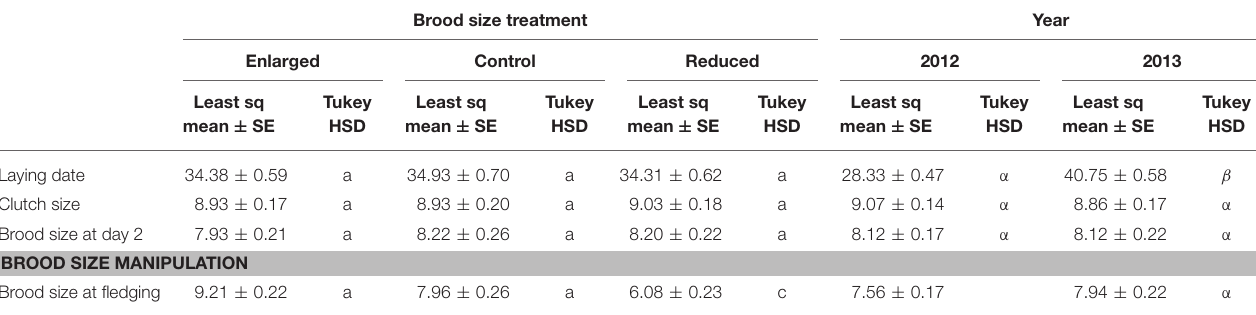
TABLE 1 | Least square means ± SE for reproductive variables according to experimental treatments (reduced: N = 54; enlarged: N = 57; control: N = 39) and year (2012: N = 93; 2013: N =